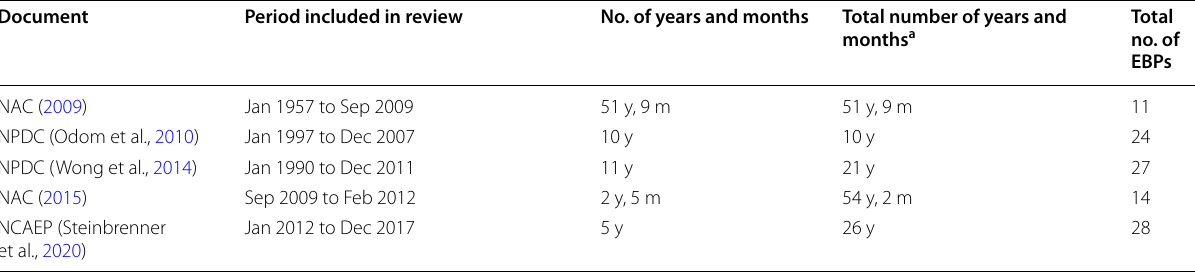
Table 2 Period, number of years and months, and total number of EBPs described in each review